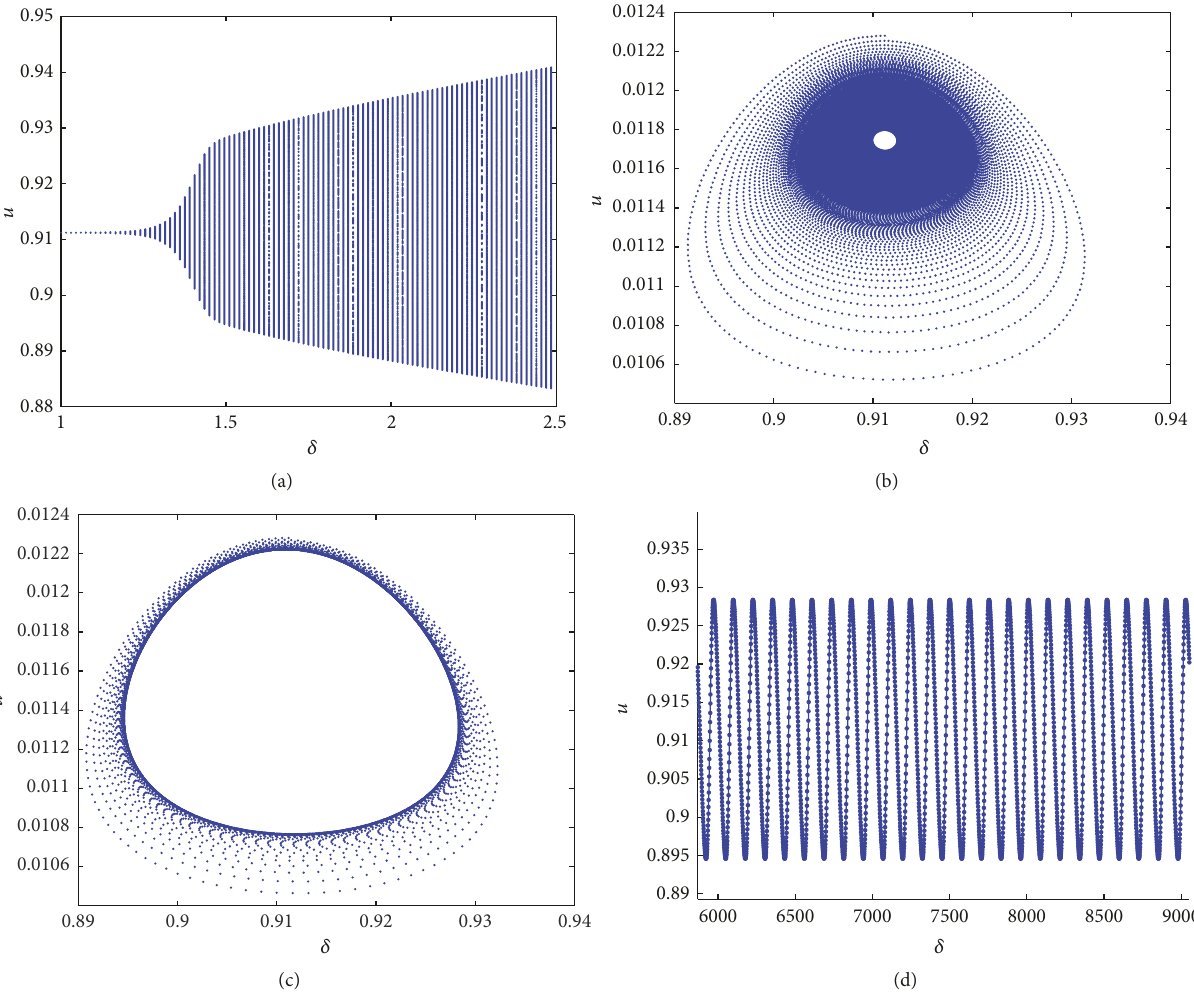
Figure 3: The initial value is (0.9112, 0.01228) , (a) the bifurcation diagram in 𝛿 - 𝑢 plane, it exhibits the dynamical behaviors of model (5), (b) 𝛿 = 1 , the equilibrium point is stable, (c) 𝛿 = 1.5 , one invariant closed curve emerges from the equilibrium point, and (d) the solution curve when 𝛿 = 1.5 , which shows that the invariant closed curve is not orbit of model